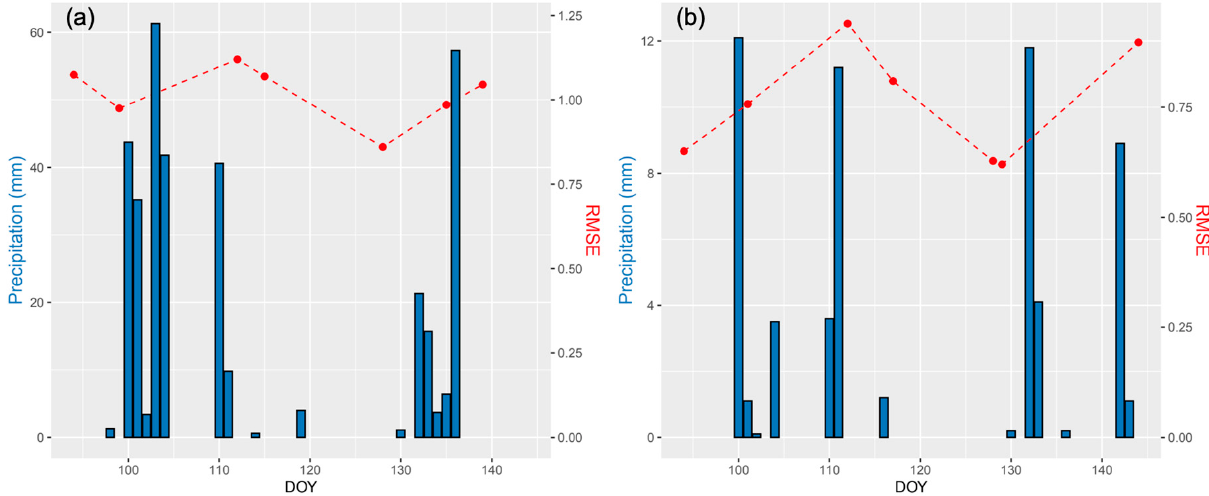
Figure 3. Time series of precipitation and root mean squared error ( RMSE ) on different days of the year (DOYs) for Phaeozems ( a ) and Arenosols ( b ). The x -axis values corresponding to the red dots represent the optimal pixel dates of training samples based on 7 images. The histogram values denote the precipitation on different dates. Notably, a smaller RMSE value indicates a higher prediction accuracy, whereas a larger RMSE value indicates a lower prediction accuracy.